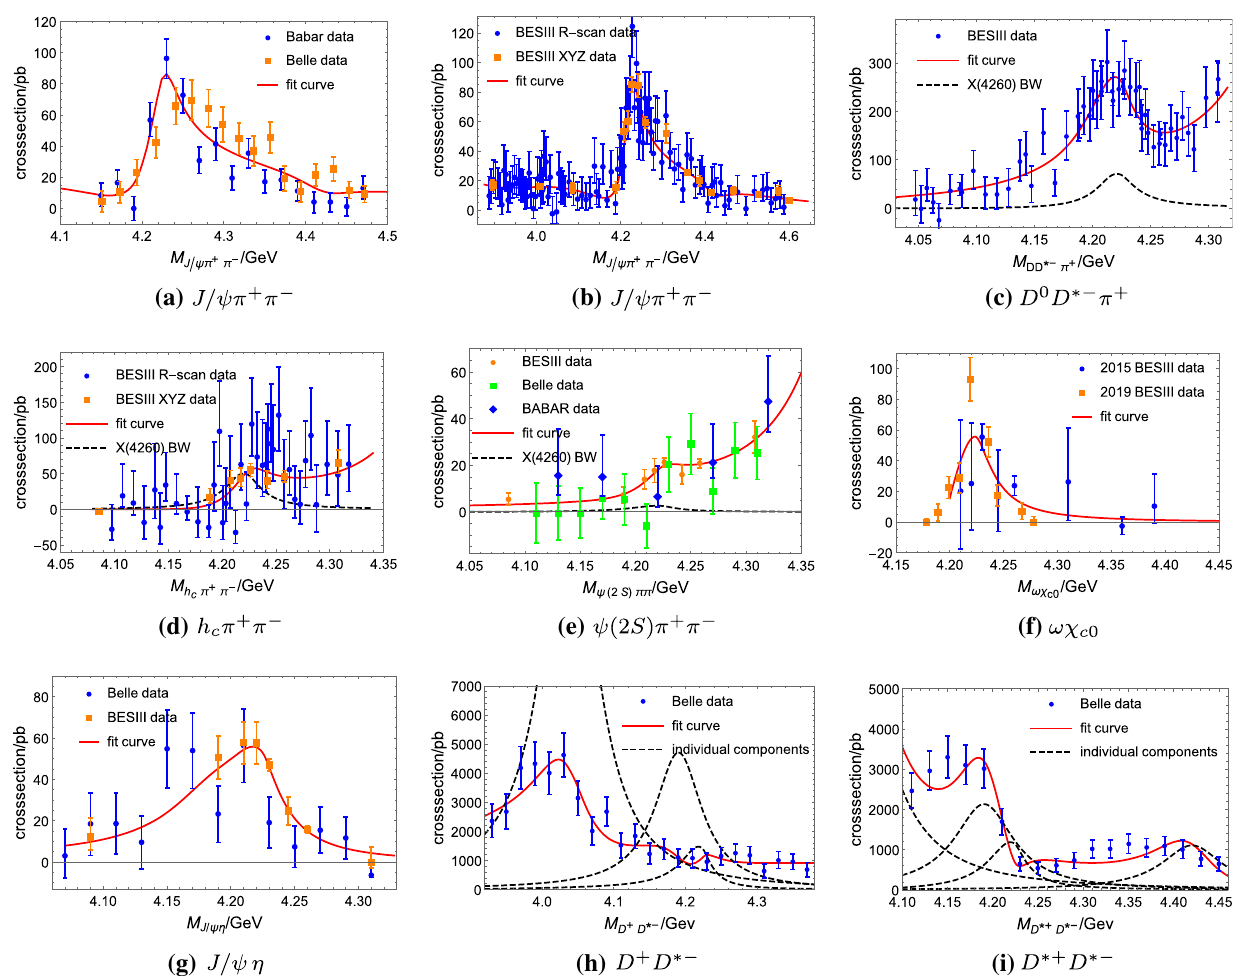
Fig. 4 The results of the fit without D ∗+ s D ∗− s cross section data, where the descriptions of the components in subgraphs are similar to those of Fig. 3